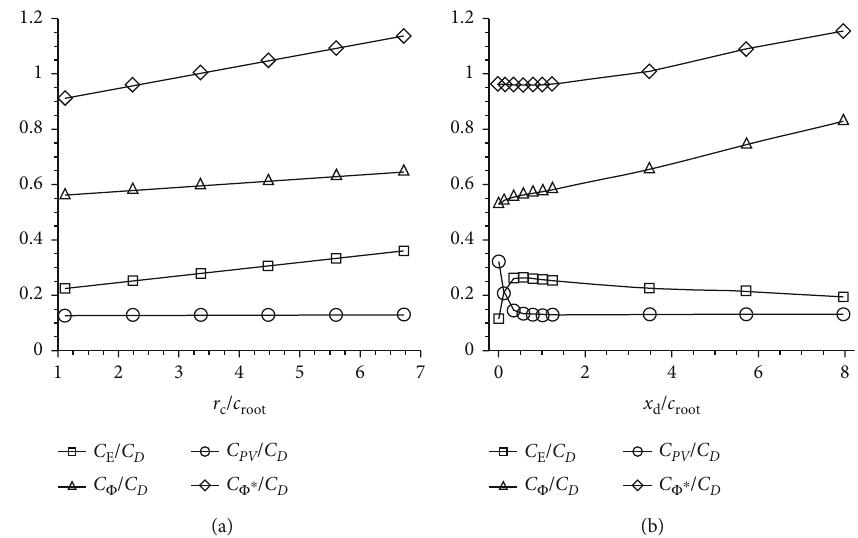
C − C , and C _ to the integral volume size. The values are normalized by near- fi eld drag coe ffi cient C Φ ∗ , Φ , PV E , and C _ with normalized integral volume size indicator r c / c PV E . root